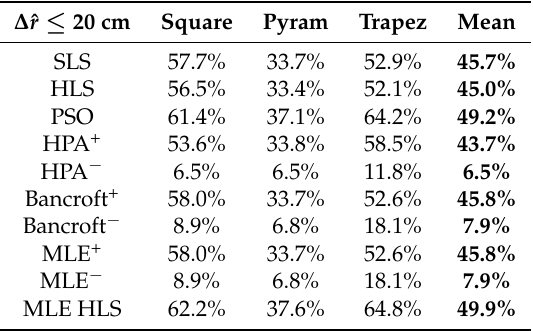
Table 6. Percentage of positions located with a radius error ∆ ˆ r lower than 20 cm under time sampled digitizing error for each algorithm and antenna array